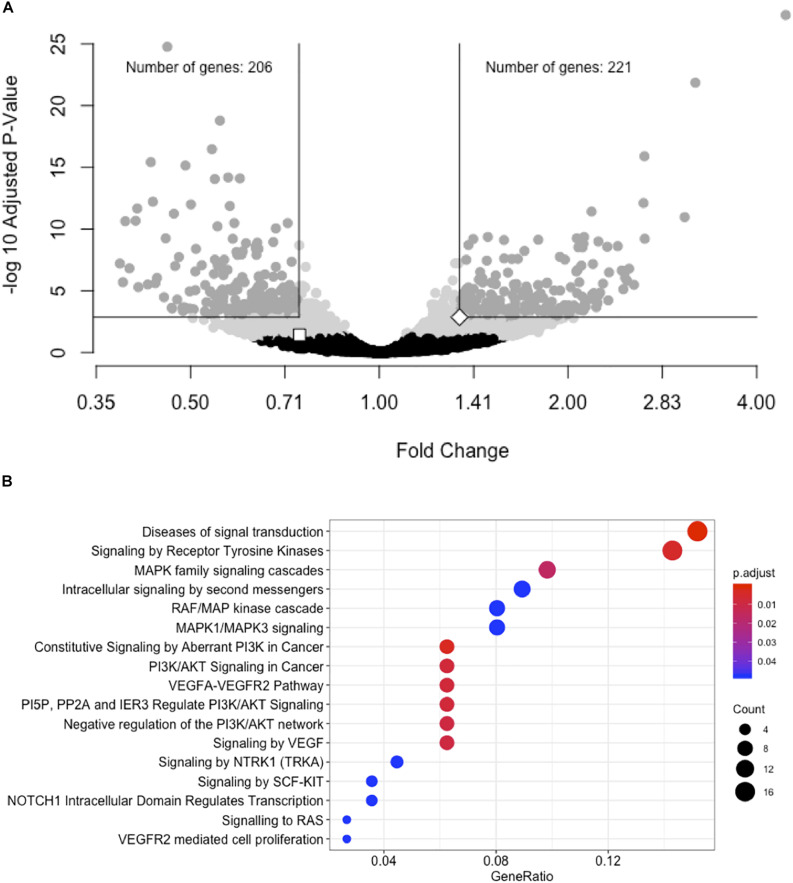
siRNA knockdown of LOC157273 using transcriptome-wide differential expression analysis in rs4841132 G/G genotype human hepatocytes results in significant expression changes in hundreds of transcripts, including LOC157273, PPP1R3B, and numerous putative trans targets. (A) Volcano plot showing the fold change effect of siRNA-11 and siRNA-15 knockdowns combined (X axis), compared with controls, with gray points indicating significant change in transcript expression (family-wise Padj < 0.05) (Y axis). The white square point indicates the LOC157273 transcript and shows that its knockdown reduced its expression (fold change = 0.74, P = 0.004, Padj = 0.04), as expected for a successful knockdown experiment. The white diamond point indicates the PPP1R3B transcript and shows that LOC157273 knockdown increased PPP1R3B expression 34% (fold change = 1.34, P = 4.5 × 10–5, Padj = 0.001). (B) Reactome enrichment analysis of genes with increased expression after siRNA-11 or siRNA-15 knockdown compared to controls (221 dark gray points in Panel (A); fold change > 1.34 and Padj < 0.001). Each row represents a significant Reactome pathway (family-wise P < 0.05) with GeneRatio (X axis) showing the degree to which the differentially expressed genes were enriched in the pathway. The count of differentially expressed genes within each pathway is depicted with the size of the circles, and the significance of the enrichment is depicted with the color of the circles.